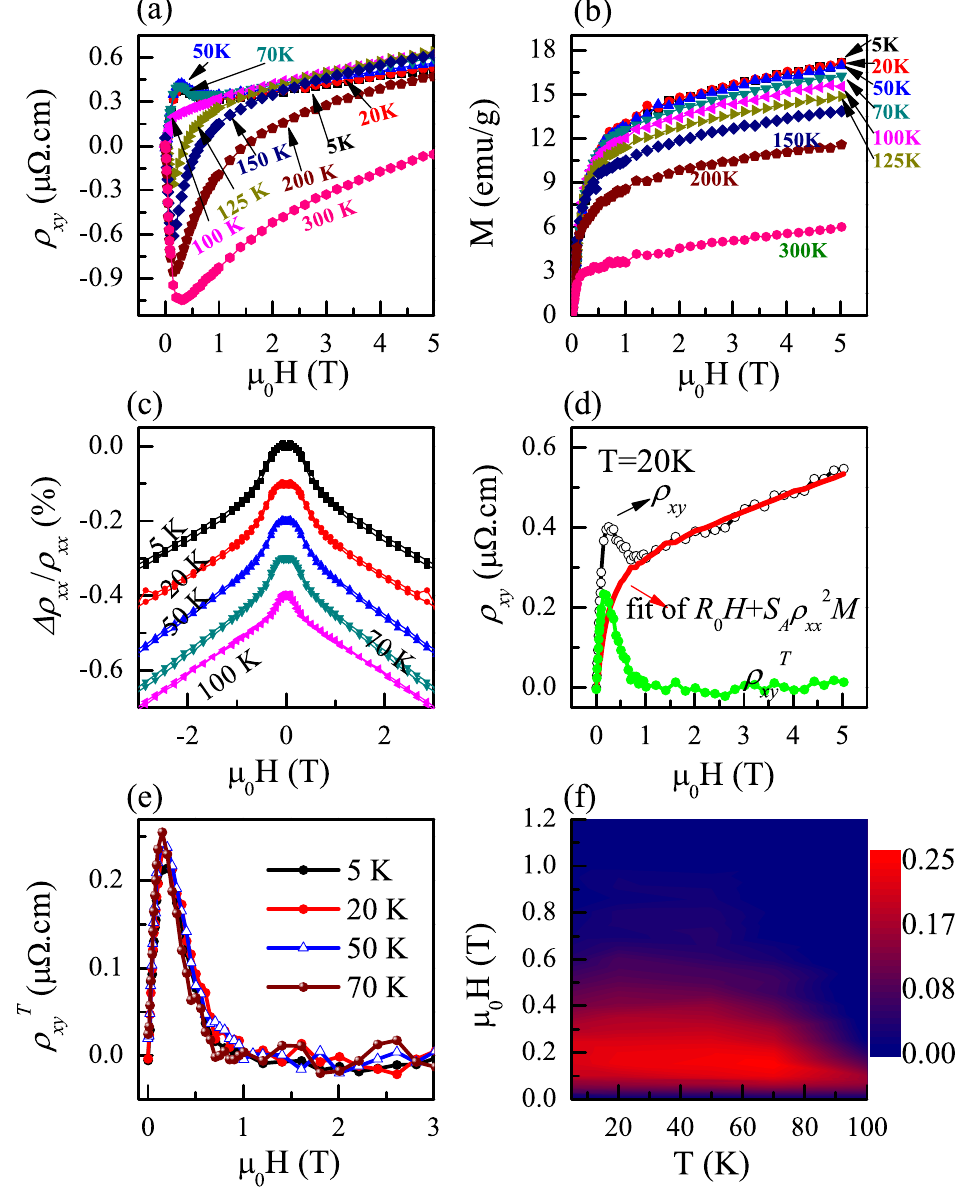
Figure 4. ( a ) Initial Hall resistivity ρ xy measured at various temperatures from 5 K to 300 K; ( b ) M-H curves measured for Mn 3 Ga thin plate with field direction perpendicular to the sample plane; ( c ) Magnetoresistivity measured at different temperatures; ( d ) The representative ρ xy - H curve (black circle) measured at 20 K, 2 curve (red line), and derived topological resistivity ρ ( ) xyT ; ( e ) ρ xyT at various calculated ρ + R H S M A xx 0 temperatures extracted from ρ xy - T curves in ( a ); ( f ) The contour mapping of extracted ρ xyT as a function of the external magnetic field H and temperature.